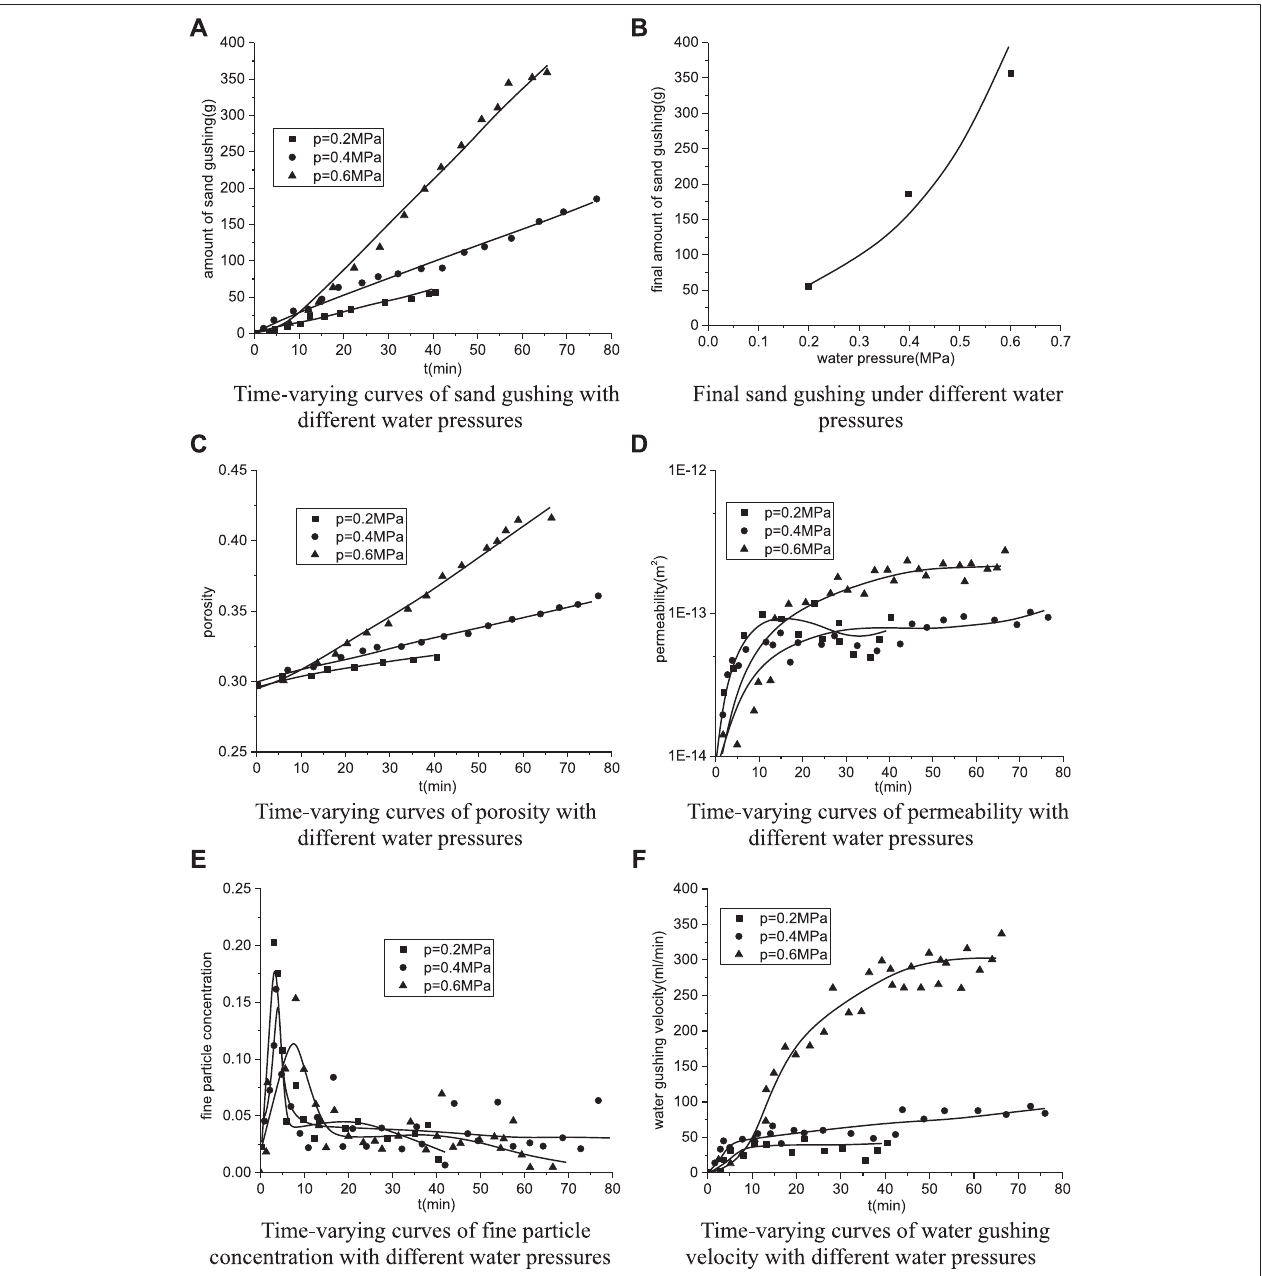
FIGURE 11 | In fl uence of water pressure on the evolution of water bursting and sand gushing: (A) time-varying curves of sand gushing with different water pressures, (B) fi nal sand gushing under different water pressures, (C) time-varying curves of porosity with different water pressures, (D) time-varying curves of permeability with different water pressures, (E) time-varying curves of fi ne particle concentration with different water pressures, and (F) time-varying curves of water gushing velocity with different water pressures.